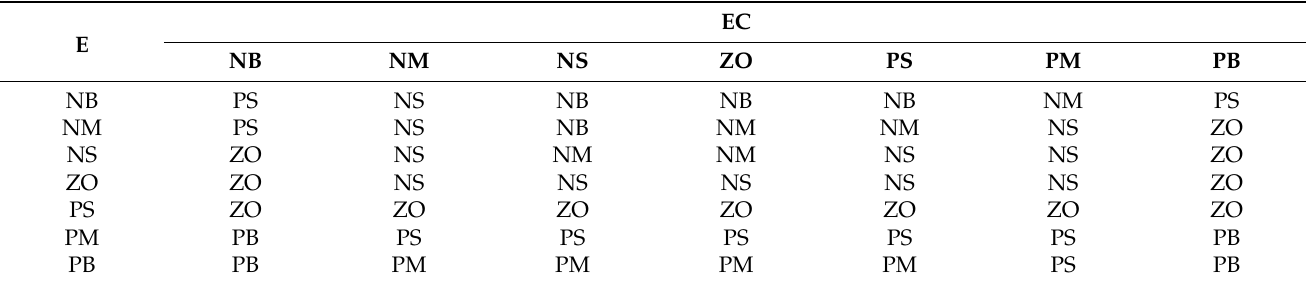
Table 3. The fuzzy control rules of differential